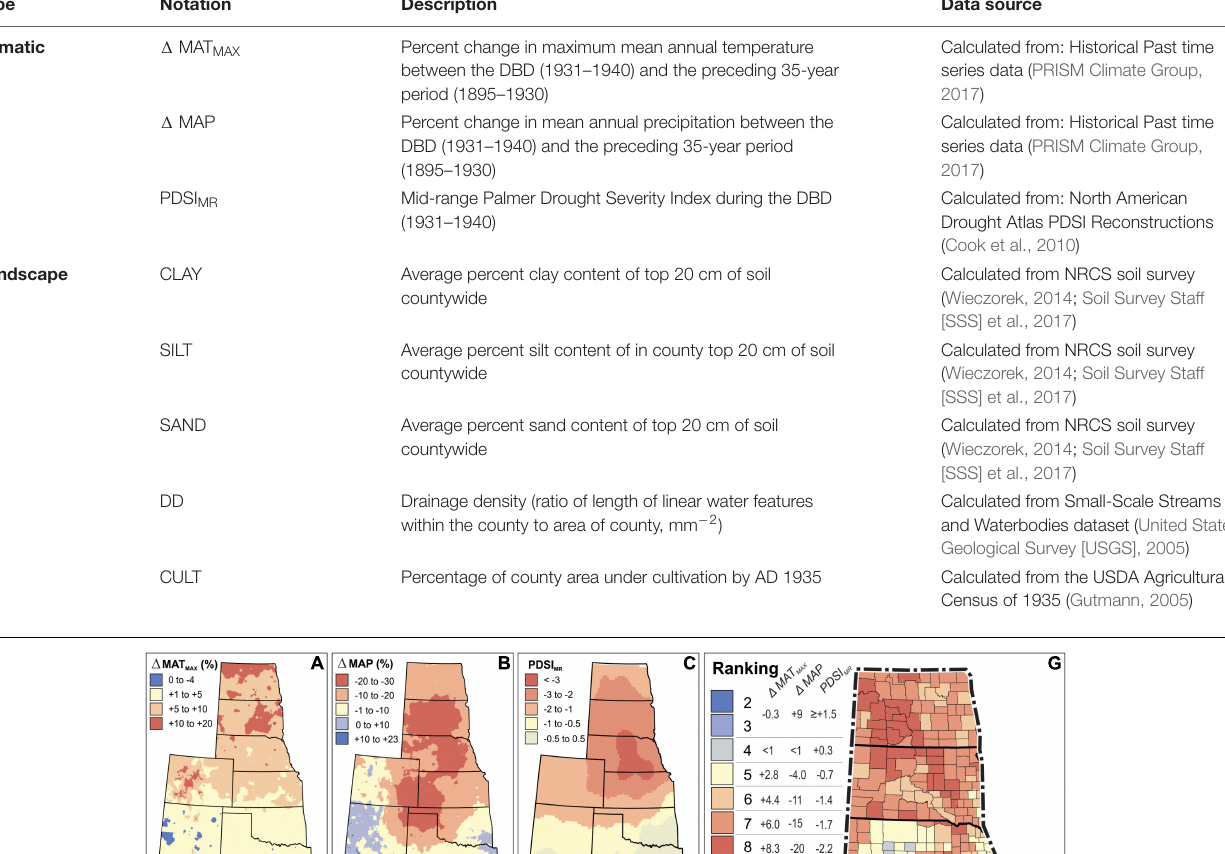
TABLE 1 | Criteria included in the weighted overlay for site identification (with Figure 5 ).